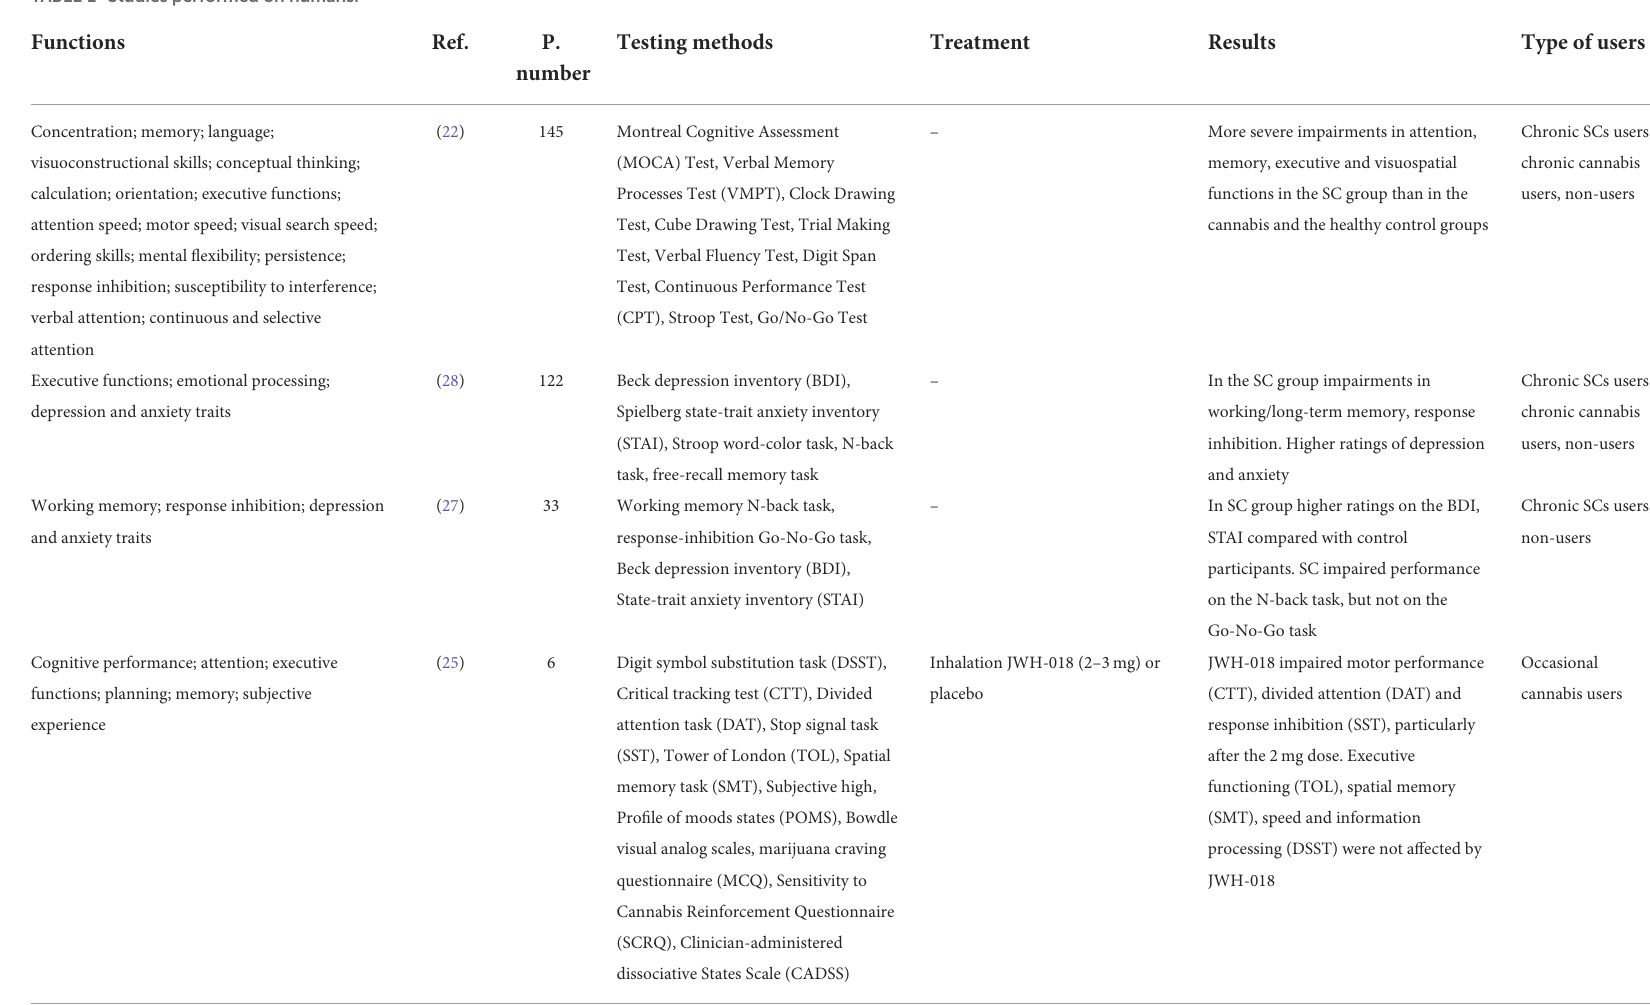
TABLE 1 Studies performed on